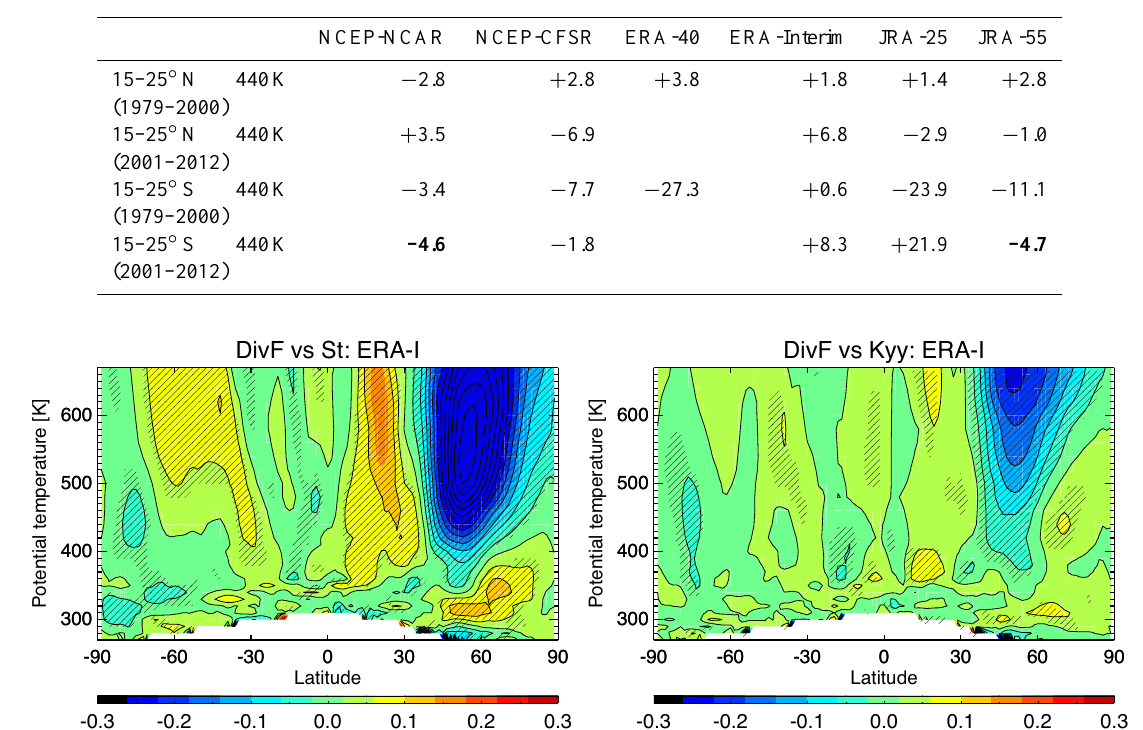
Table 8. Linear trend slope of the relative importance of the eddy transport to the total meridional transport (in %decade − 1 ) for 15–25 ◦ N in DJF, and for 15–25 ◦ S in JJA at 440K during the first 22 years (1979–2000), and during the last 12 years (2001–2012). The linear trend with a confidence level greater than 95% is shown in bold.